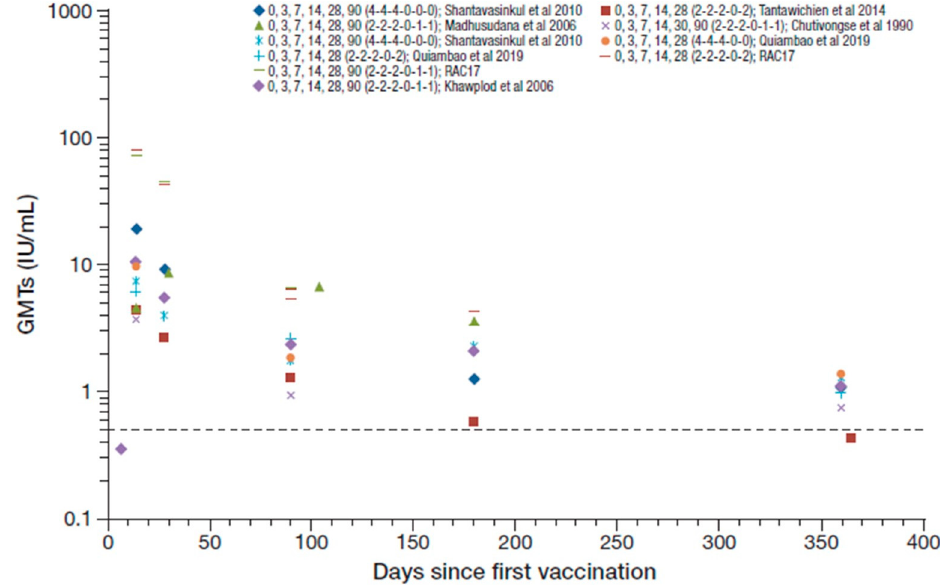
Figure 4. Summary of PEP immunogenicity data from studies with PVRV ID and concomitant rabies immune globulin (RIG) administration [regimen summarized as day of vaccination (number of sites per vaccination day) in legend key]. Dotted line marks the 0.5 IU/mL RVNA titer.